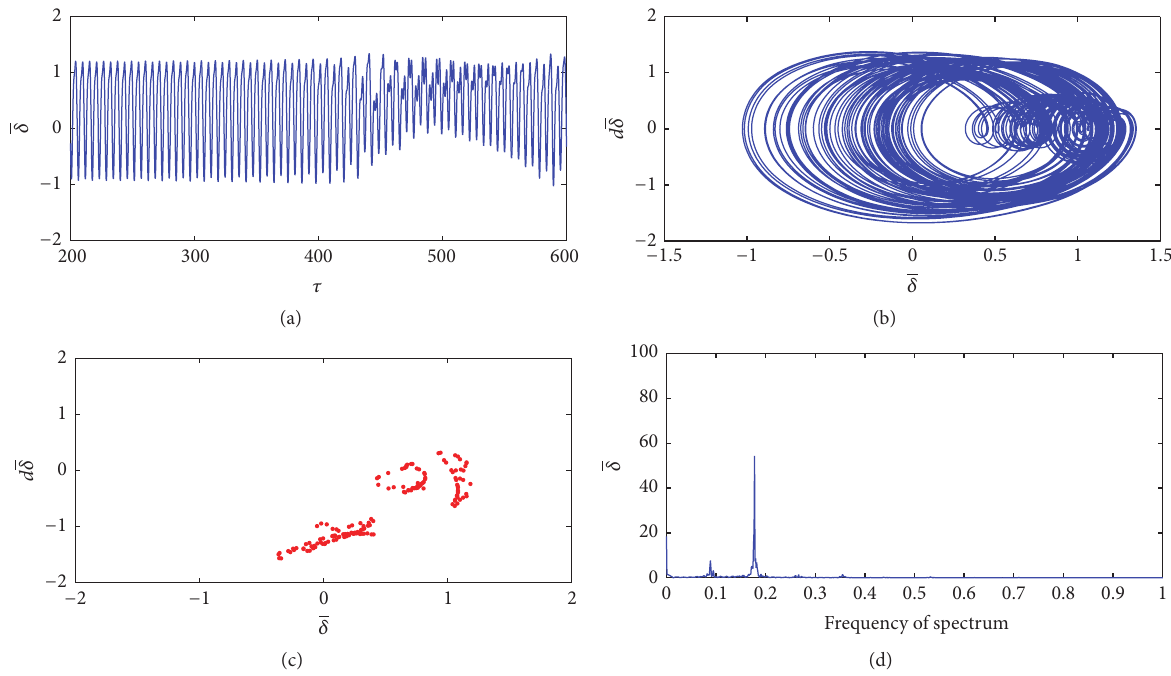
Figure 14: 𝑏 = 80 𝜇 m: (a) time history; (b) phase plane; (c) Poincar´e map; (d) Fourier spectrum.